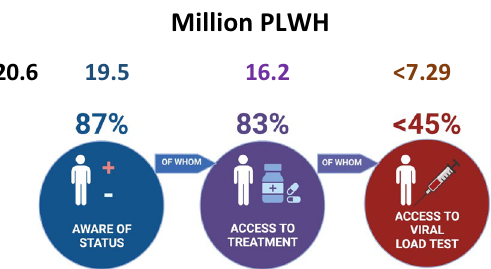
Figure 1. The percentages of people living with HIV + in Eastern and Southern Africa who are aware of their HIV status, who have access to combination antiretroviral therapy and who have access to viral load treatment- monitoring 1 . Created with